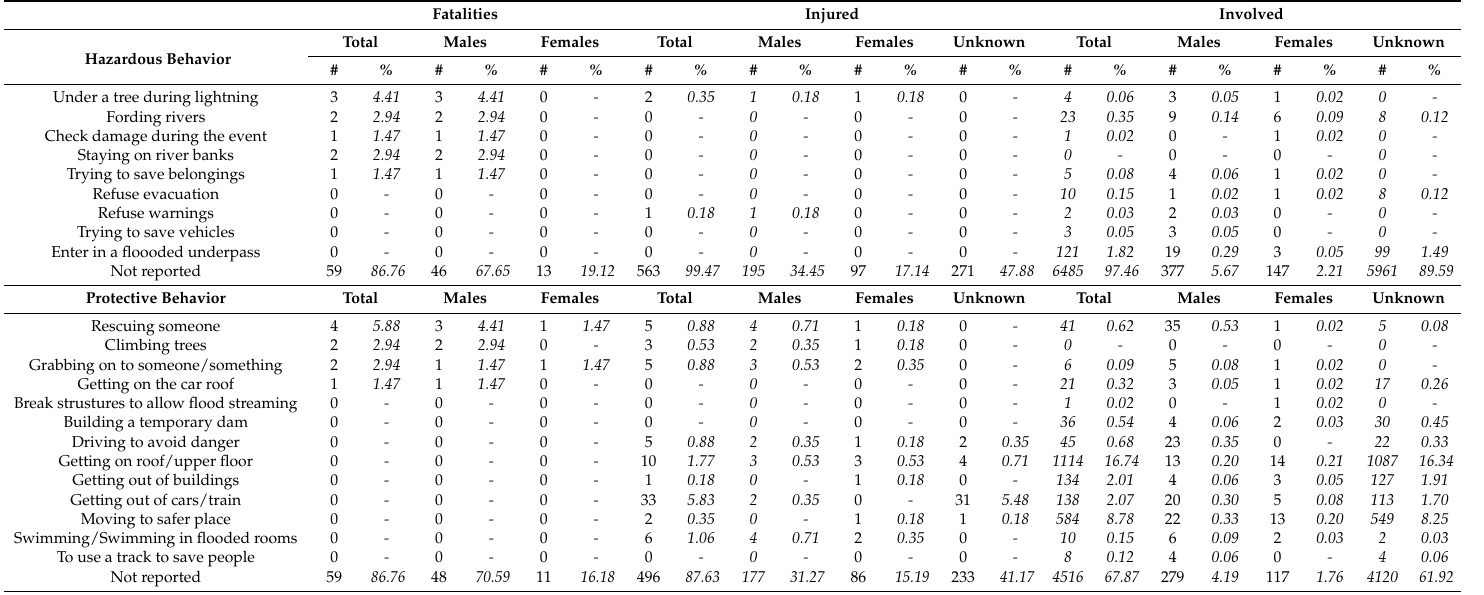
Table 9. Gender and hazardous and protective